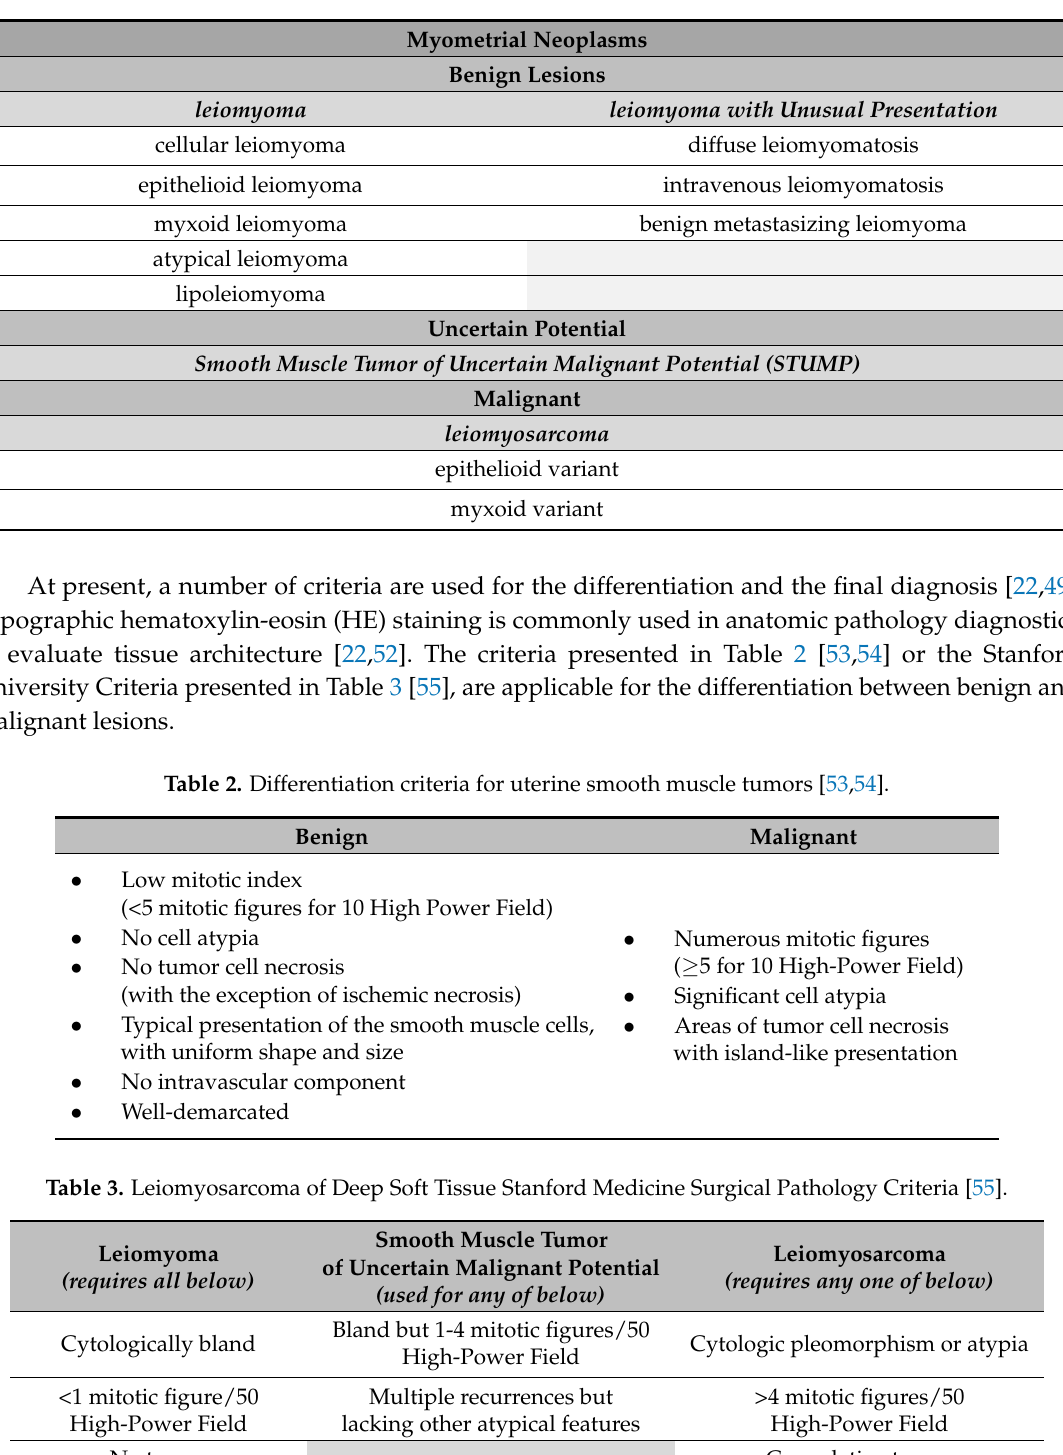
Table 1. The 2014 classification of smooth muscle tumors according to the World Health Organization (WHO) [51].